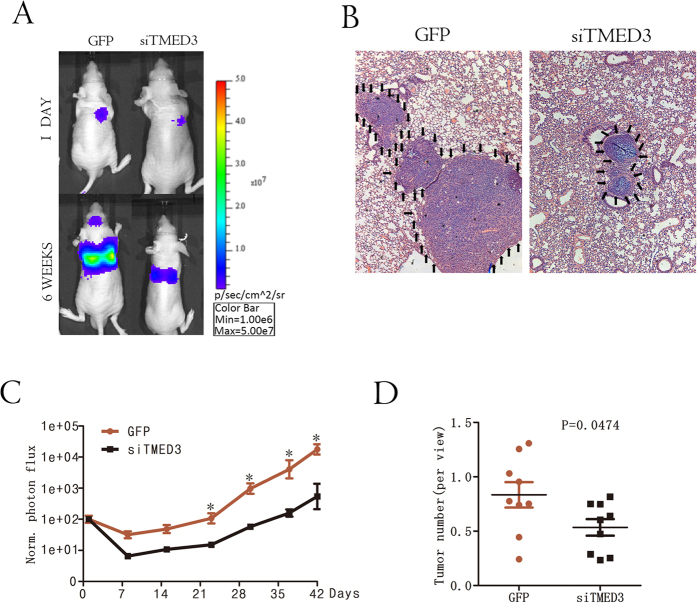
TMED3 promotes HCC metastasis in vivo.(A) Lung metastases that developed after injecting HepG2 cell lines in the lateral tail vein were imaged using the IVIS Imaging System. Representative luciferase signals captured in each group (n = 9) at initial injection and after 42 days are shown. The statistical analysis is shown in (C), n = 9, mean ± SD, the Student’s t test, *p < 0.05 versus GFP control. (B) Representative imaged of H&E-stained lung metastatic loci from each group in (A). The statistical analysis is shown in (D).